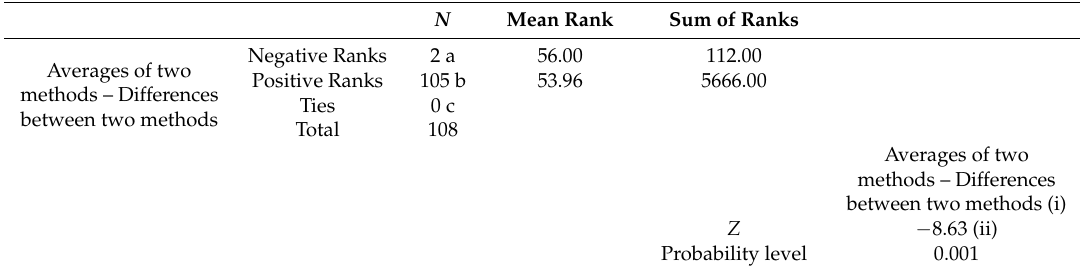
Table 3. Equivalency analysis examining whether estimates are equivalent at the group